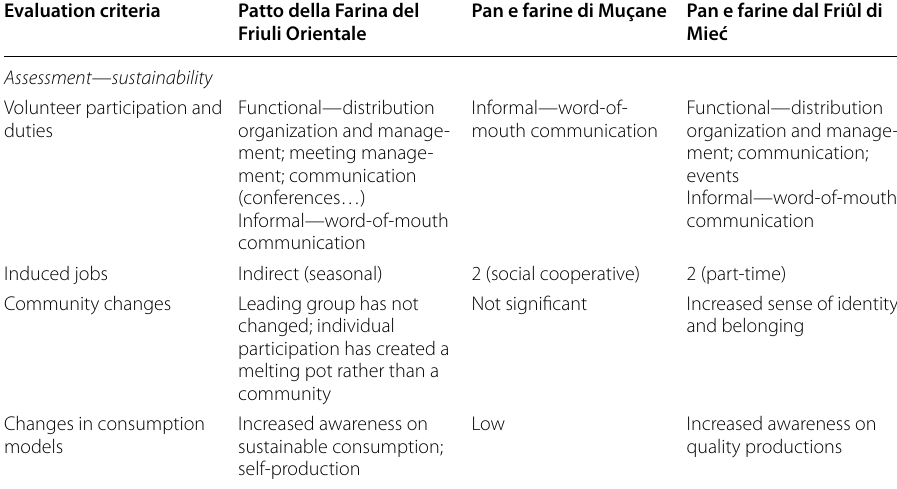
Table 4 Assessment—sustainability Evaluation